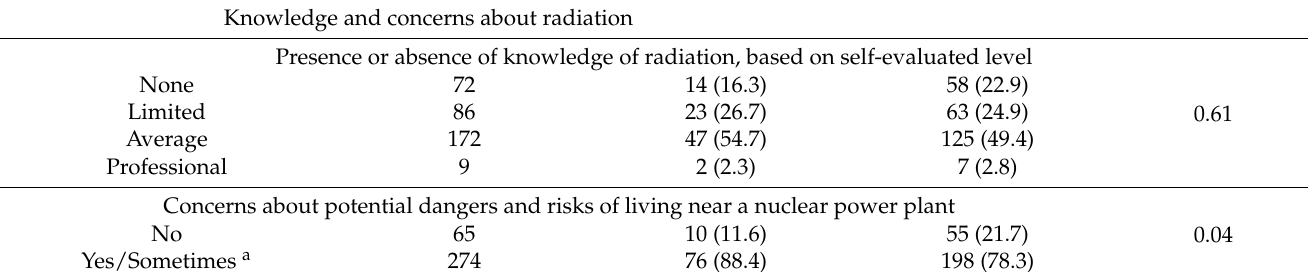
Numbers by Characteristic (%) p Value Total The Non-Affected (Chi-Square)The Affected Group N = 339 Group N = 86 N =